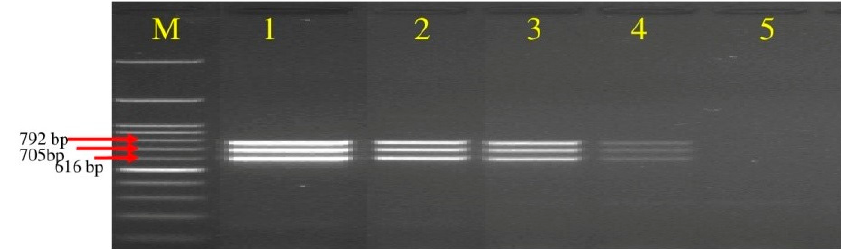
Figure 3. Sensitivity of the primers designed based on three polyketide antibiotic synthase genes i.e., difficidin, macrolactin and bacillaene of Bacillus amplified at 705 bp, 792 bp and 616 bp using multiplex–PCR, respectively. Lane M: 100 bp DNA Ladder: Lane 1: 100 ng/µL DNA of B. amyloliq- uefaciens (DSBAS-11); 2: 10 ng/µL; 3: 1.0 ng/µL; 4: 0.1 ng/µL 5: -ve control .